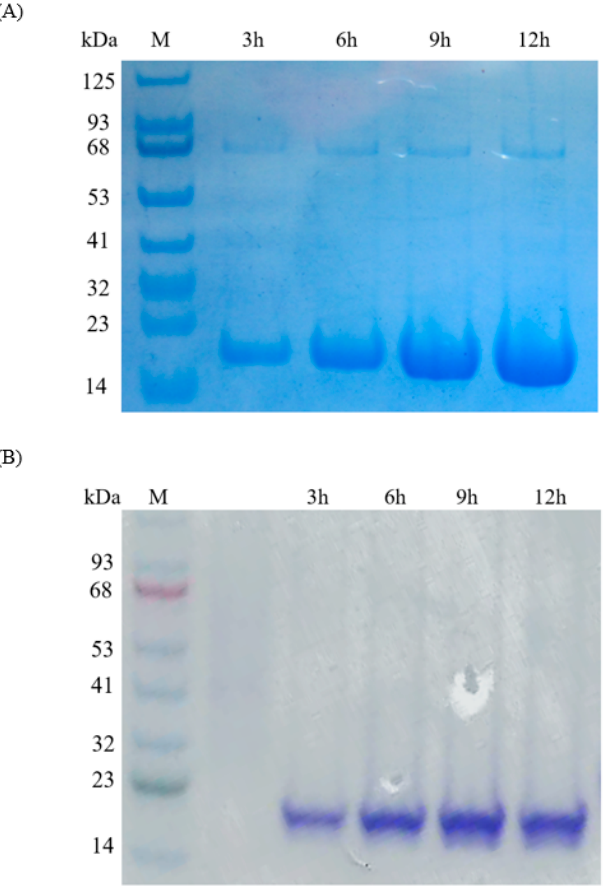
Figure 4. SDS − PAGE of the purified IFN- α from ( A ) E. coli and ( B ) B. subtilis overexpression systems at various induction time. Lane M, protein marker. E. coli and B. subtilis cells harboring plasmids encoding IFN were induced by 0.2 mM IPTG at 24 °C for 3, 6, 9, 12 h.